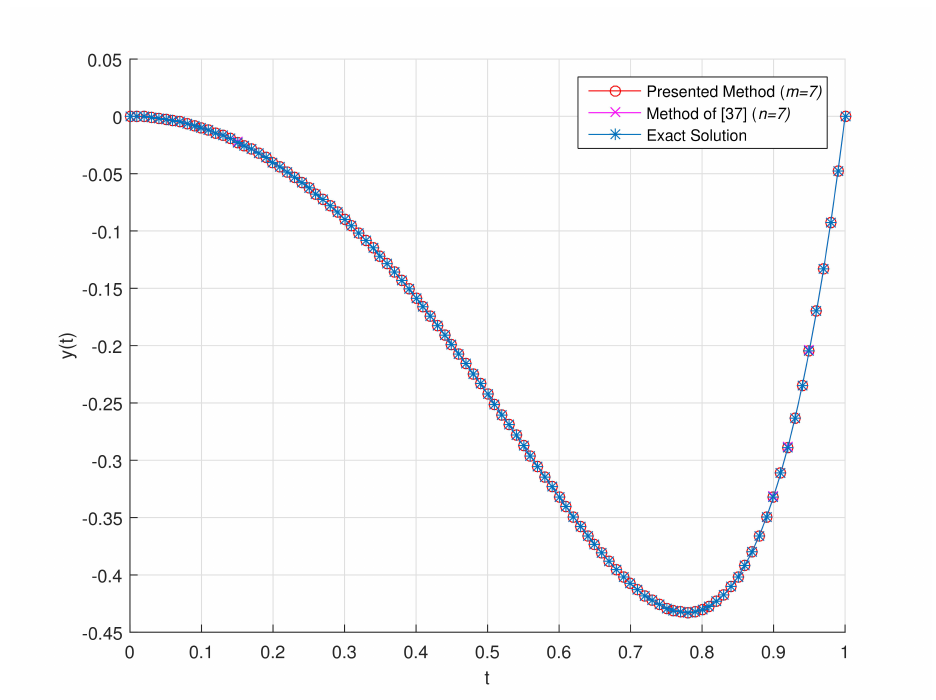
Figure 3. The comparison between exact solution and the numerical solutions obtained by proposed method and the method of [59] with m , n = 7.